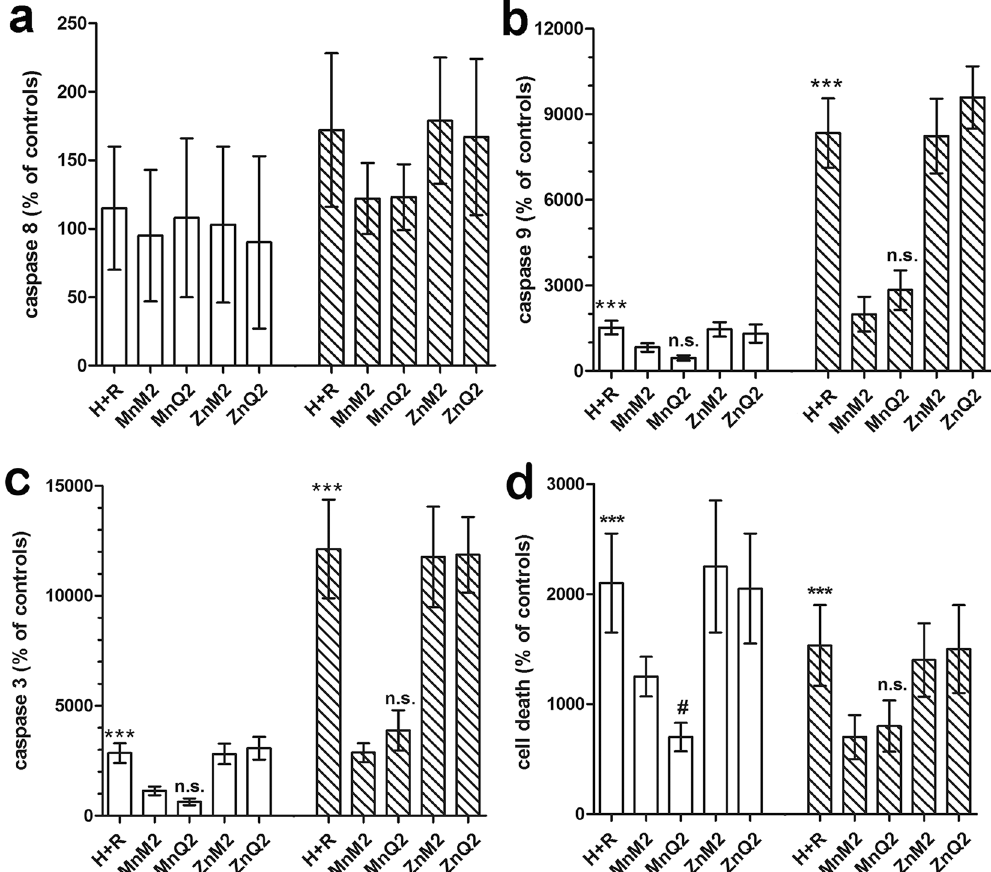
Figure 9. FACS analysis of fluorescent reporter activity of apoptosis initiator caspases 8 ( a ) and 9 ( b ), of apoptosis effector caspase 3 ( c ) and of cell death assayed by LDH release ( d ), evaluated at 1 h (open columns) and 2 h (striped columns) and expressed as percent changes of the untreated controls. Caspase 8, involved in the extrinsic apoptotic pathway, was unaffected by any treatment and exposure times. Conversely, caspase 9, involved in the intrinsic apoptotic pathway, was increased by H + R and significantly decreased by MnQ2 and MnM2. Caspase 3 and overall cell death were increased by H + R and significantly decreased by MnQ2 and MnM2. At the shorter time point (1 h), MnQ2 was significantly more effective than MnM2 to reduce cell death. *** p < 0.001 vs. controls, MnM2 and MnQ2; (one-way ANOVA); # p < 0.05, n.s. not significant vs. MnM2 (Student’s t